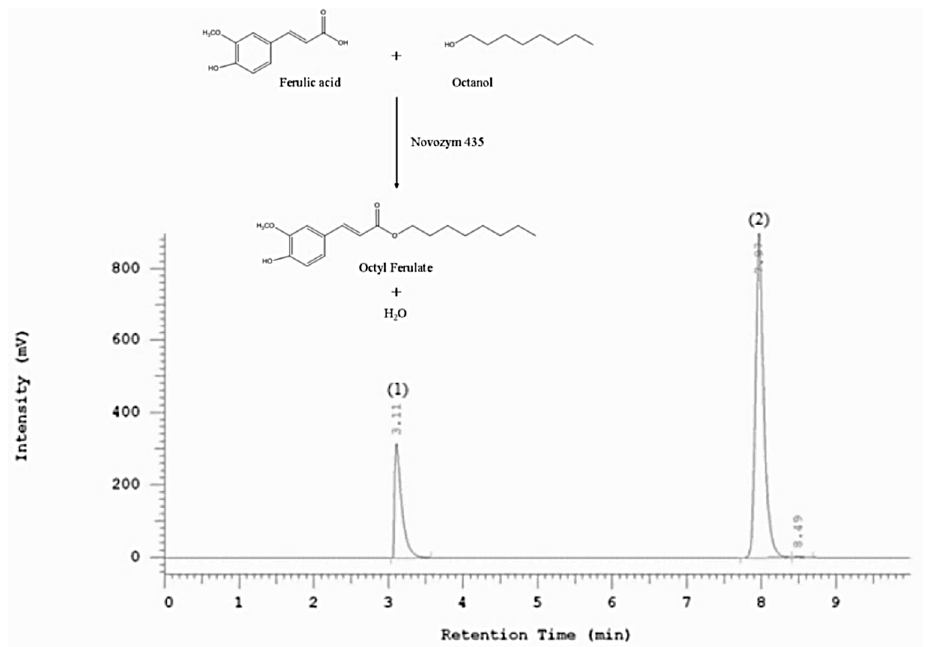
Figure 1. Scheme of octyl ferulate synthesis and high-performance liquid chromatography (HPLC) chromatogram. Peak 1 of HPLC chromatogram is ferulic acid, and peak 2 is octyl ferulate.